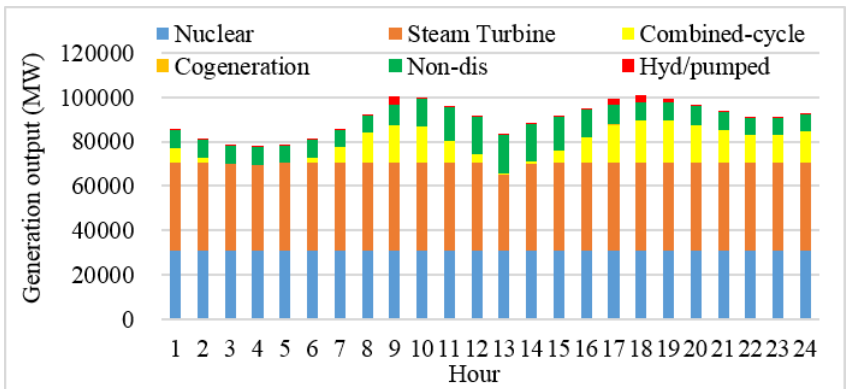
Figure 6. The calculated generation schedule for the peak-load day in 2029.